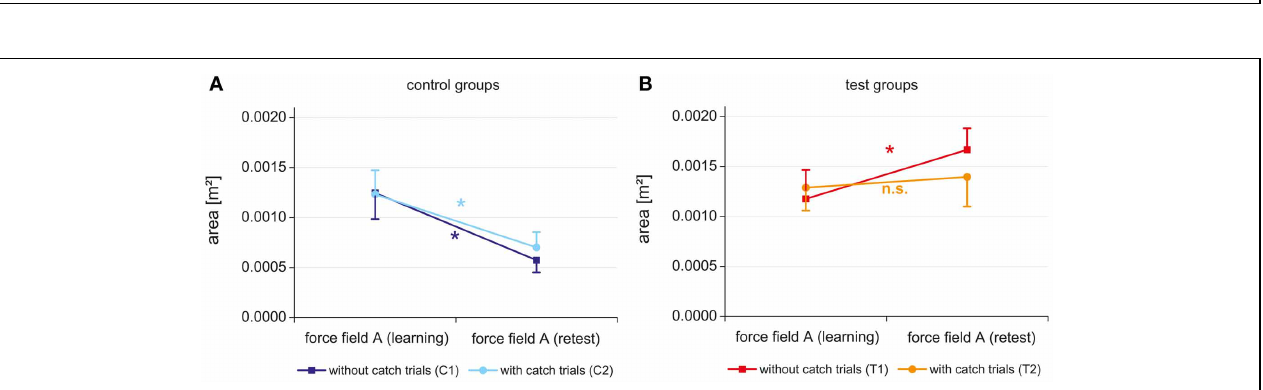
FIGURE 5 | Initial performance (mean score of the first block) in force field A of day 1 and day 3 for the control groups with and without catch trials (A) and the test groups with and without catch trials